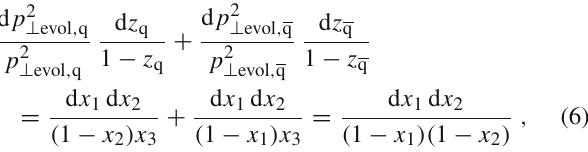
Fig. 3 Sketch of the branching a → b + c with a recoiler r . The z -axis is chosen to be along the direction of the momentum of parton a